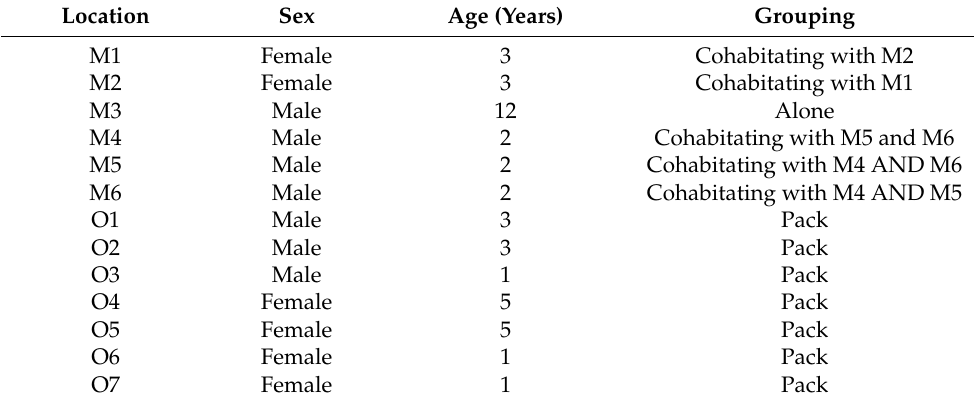
Table 1. Fecal samples collected according to location, sex, age, and type of grouping from two popu- lations of Mexican wolves (Canis lupus baileyi) in Michilia (M, 23 ◦ N) and Ocotal (O, 19 ◦ N), Mexico. Location Sex Age (Years) Grouping M1 Female